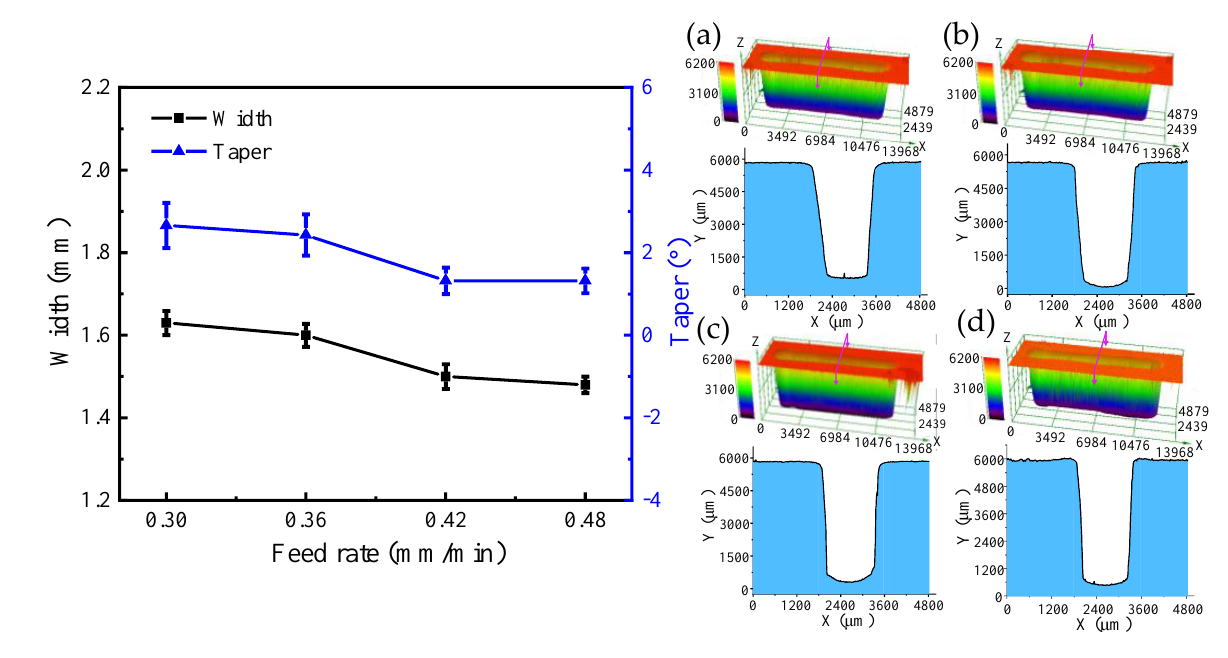
Figure 16. The dimension and 3D profile of DNGs milled with different feed rates: ( a ) feed rate = 0.30 mm/min; ( b ) feed rate = 0.36 mm/min; ( c ) feed rate = 0.42 mm/min; and ( d ) feed rate = 0.48 mm/min. creases from 1.41 μm to 0.85 μm.